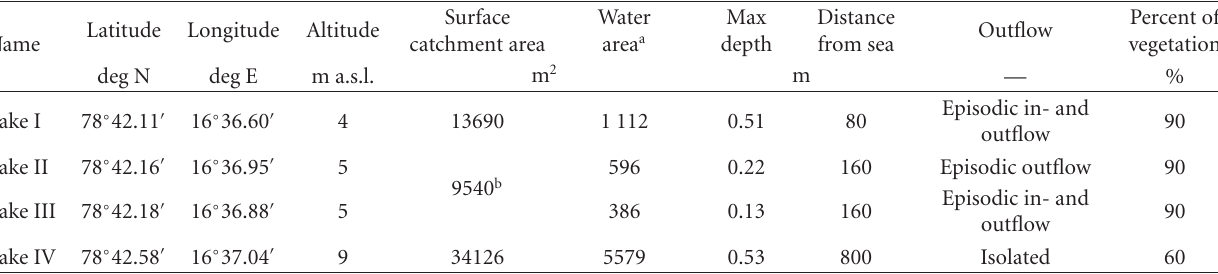
Figure 1: Location of the study area in context of Spitsbergen (a), Billefjorden (b), and Petuniabukta (c) Eb: Ebbabreen; W: Wordiekammen; L: Løvehovden; S: Skottehytta meteorological station. Lakes I–IV: tundra lakes described in this study; 1: slope deposits; 2: marine shore deposits; 3: talus cones; 4: alluvial fans; 5: marine terraces edges; 6: lakes with catchment divides, episodic streams, and lakes; 7: location of piezometers within the wetland. Table 1: Lake basins and catchment characteristics of tundra